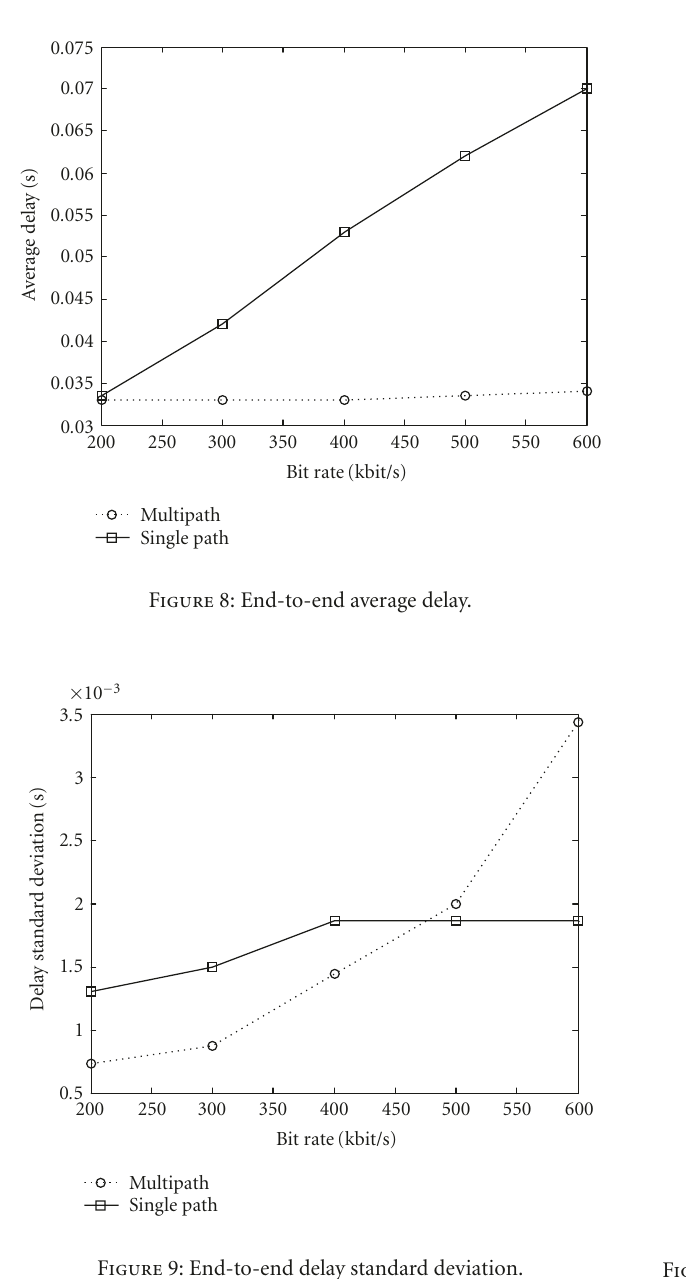
5 frame/s. According to the above definition, the greater the PSNR and the frame rate at destination are, the greater the Q parameter